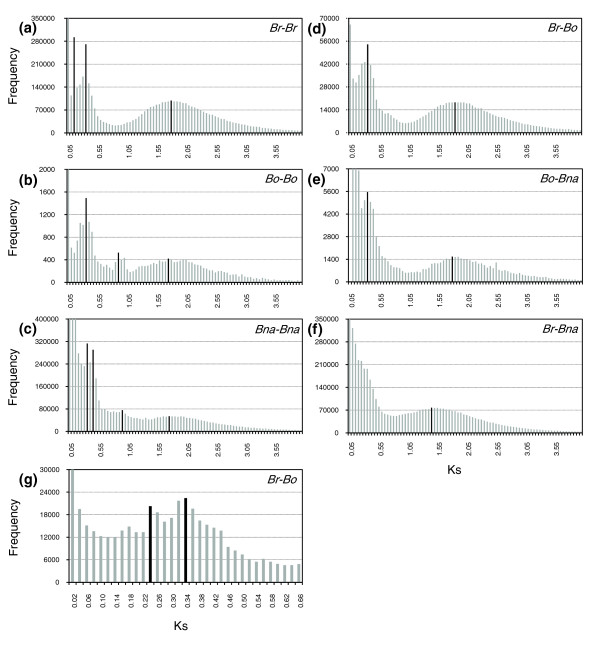
Traces of polyploidy events in the Brassica 'A' and 'C' genomes. (a-g) Distributions of Ks values were obtained from comparisons of sets of paralogous EST sequences in Br (a), Bo (b), and Bna (c) and comparisons of putative orthologous EST sequences between the genomes (d-g). The vertical axes indicate the frequency of paired sequences, and the horizontal axes denote Ks values at 0.05 (a-f) or 0.02 (g) intervals. The black bars indicate the positions of the modes of Ks distributions obtained from comparisons of orthologous or paralogous gene pairs. Bna, B. napus; Bo, B. oleracea; Br, B. rapa.